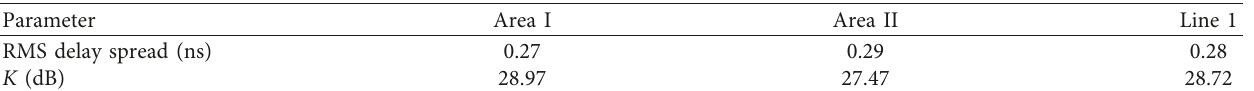
Table 5: Mean value of